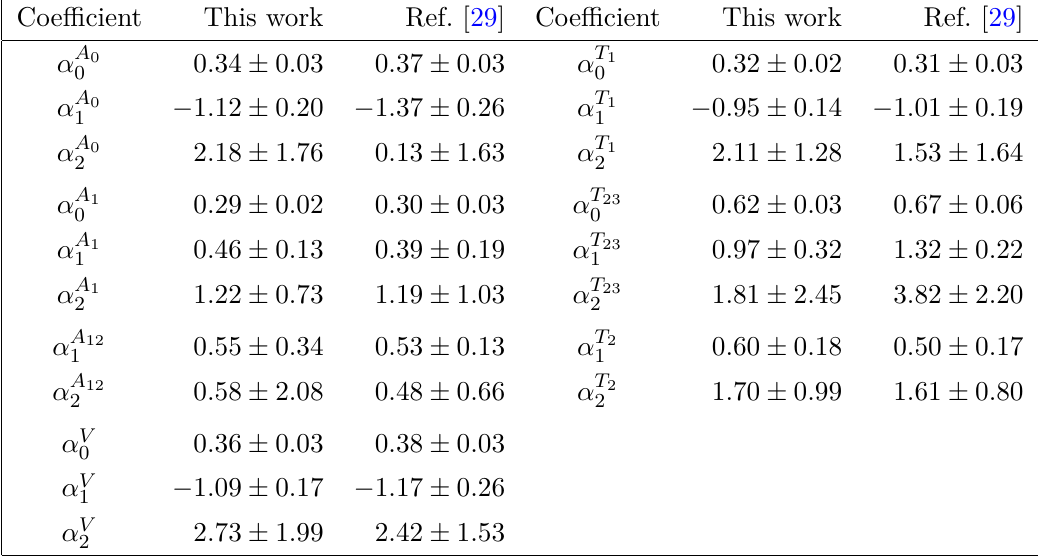
Table 10 . Posteriors of the B → K ∗ local FFs fit. We used the exact relations (A.24)–(A.25) to reduce the number of parameters to 19. The posterior distribution is accurately described with a single multivariate Gaussian distribution, whose parameters are given in the ancillary file BToKstar-local.yaml . We compare our results to those of ref. [29].